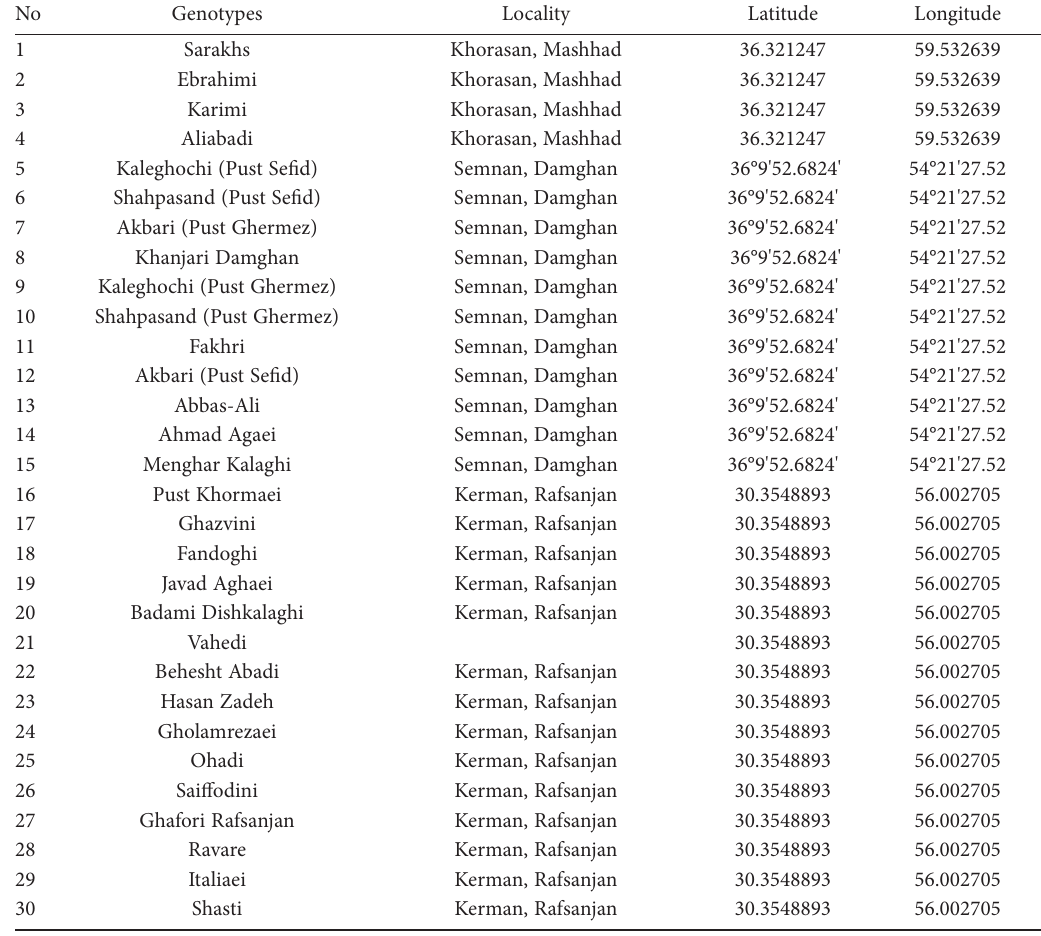
Table 1. List of pistachio cultivars examined for genetic relatedness using SCoT marker system in this study.by Majid Khayatnezhad. No